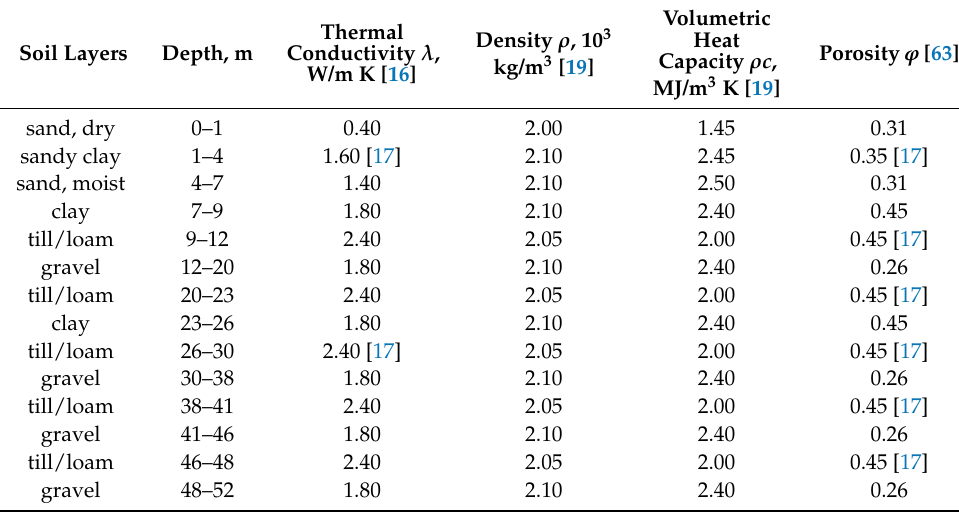
Table 2. Thermophysical properties of the underground soil